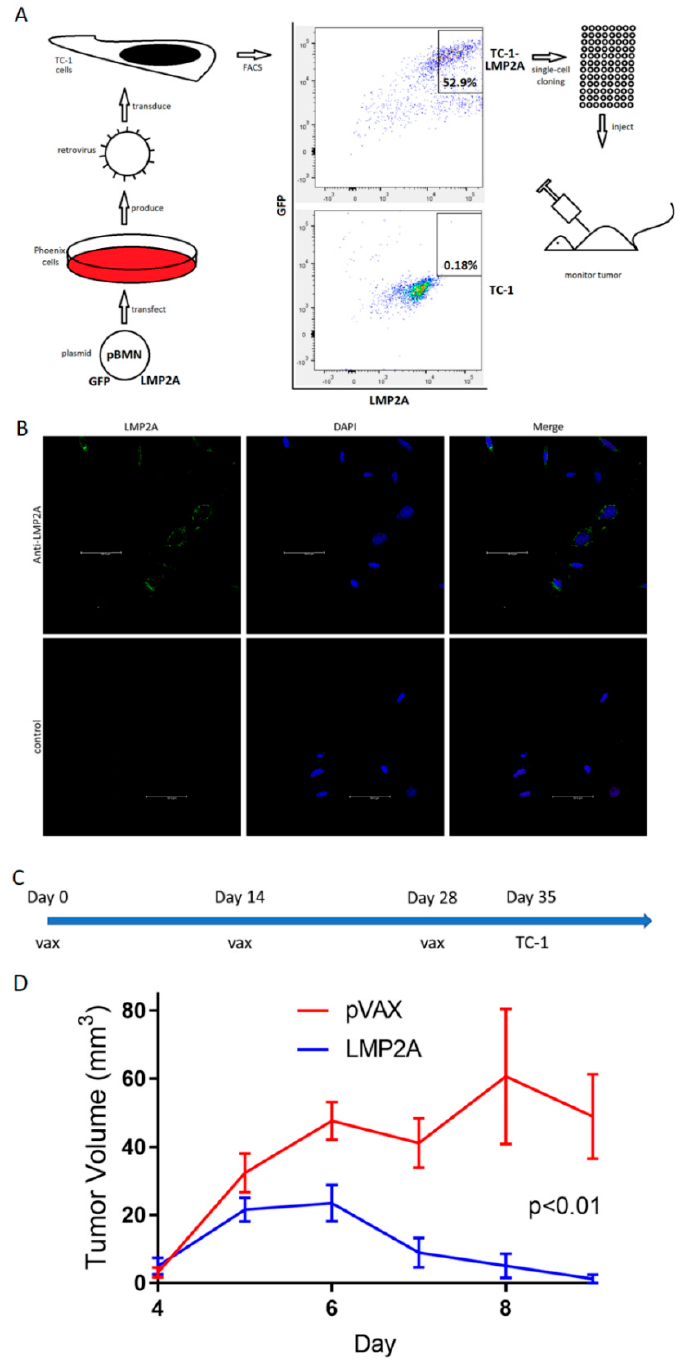
Figure 4. LMP2Avax inhibits tumor growth in mice. ( A ) Workflow to produce tumor cell lines expressing target antigen, in this case TC-1-LMP2A. ( B ) Immunofluorescence assay demonstrating LMP2A expression in TC-1-LMP2A cell line. DAPI is shown in blue, with LMP2A labeled in green. Anti-LMP2A antibodies were used as primary Abs (top), with secondary Abs conjugated to AF647. Anti-EBNA1 primary antibodies were used as a negative control (bottom). Scale bars are 50 µ m. ( C ) Vaccination schedule prior to tumor introduction. Two groups of five C57BL / 6 mice received three biweekly vaccinations followed by the subcutaneous axillary injection of 2 million TC-1 cells stably expressing LMP2A. The vaccines used 20 µ g of DNA in 30 µ L of water delivered by electroporation, with the vaccine group receiving plasmid encoding LMP2Avax and the control receiving the empty vector pVAX. Tumor sizes were monitored daily afterwards. ( D ) TC-1-LMP2A tumor volume over time in mice vaccinated with LMP2A or empty vector. Bars show scanning electron microscopy